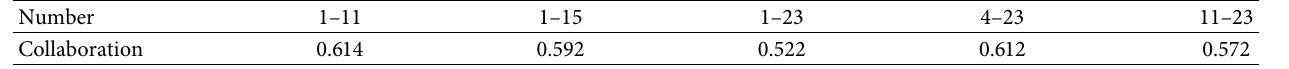
Table 5: Collaboration degree of airline transportation nodes.